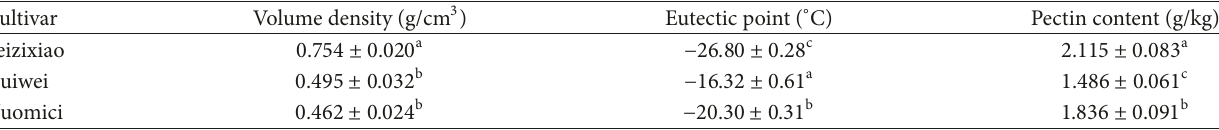
Table 1: Results of three indexes for three cultivar lychees’